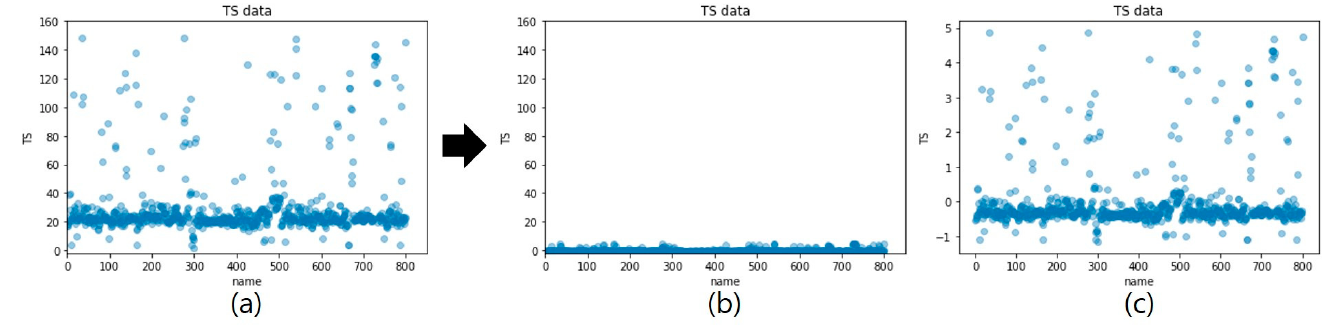
Figure 12. TS data distribution ( a ) before Z-score standardization, ( b ) after Z-score standardization, and ( c ) Z-score standardization for different y-axis scales.